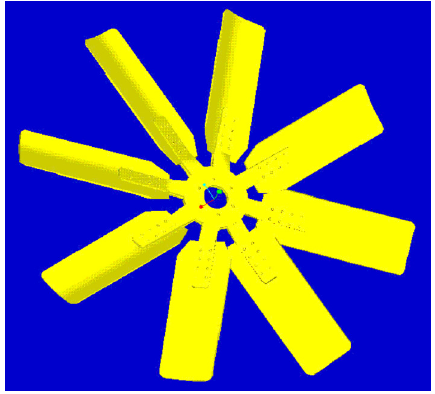
Figure 11: Static pressure distribution on pressure side of a fan blade without radiator (unit in Pascal).